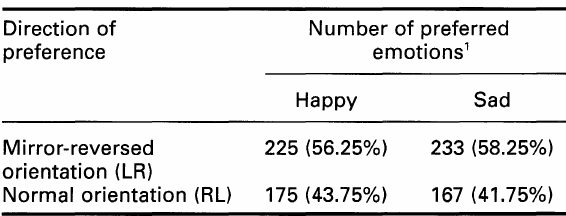
TABLE I. Preferred judgements of expression for photo graphs presented in normal and mirror-reversed orienta tion Direction of preference Mirror-reversed 225 (56.25%) 233 (58.25%) orientation (LR) Normal orientation (RL) 175 (43.75%) 167